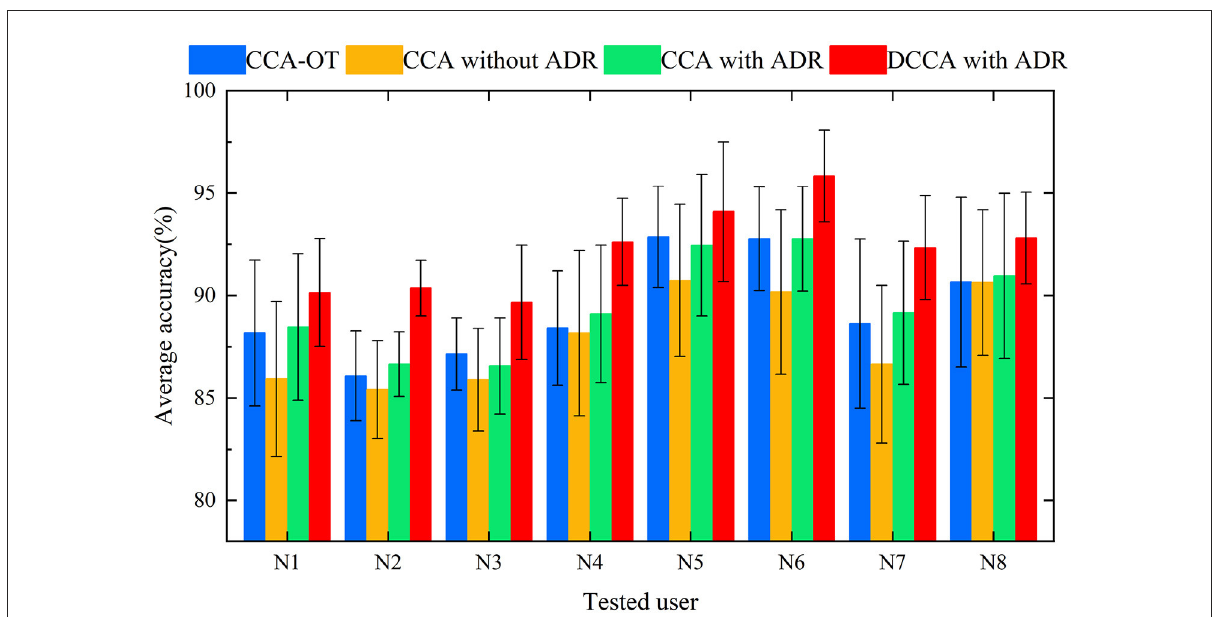
FIGURE5 Histogram of average accuracies of 12 campaigns classified by four methods for eight